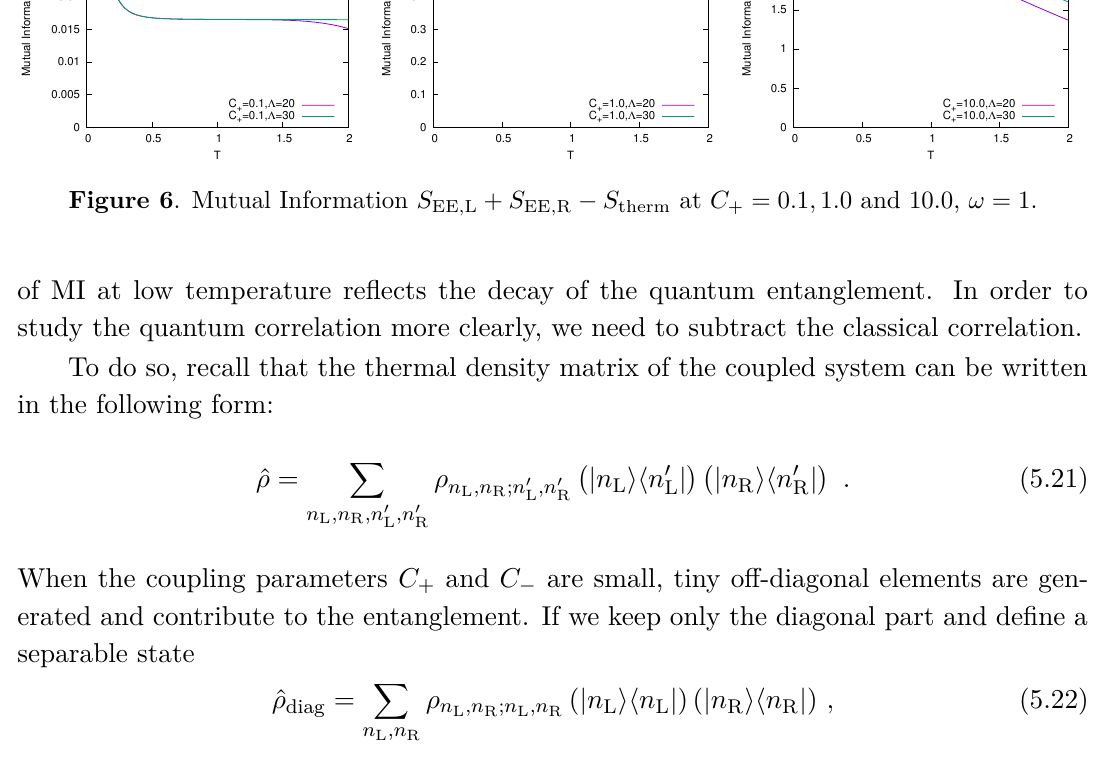
Figure 6 . Mutual Information S EE , L + S EE , R − S therm at C + = 0 . 1 , 1 . 0 and 10 . 0 , ω = 1 .